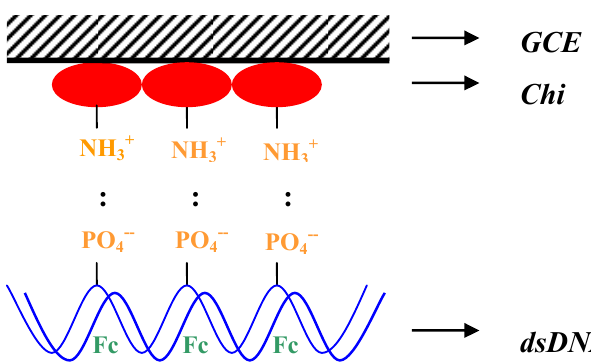
Figure 1. Scheme of the molecular mechanisms underlying electrochemical DNA detection with ferrocene. After chemical modification of the glassy carbon electrode (GCE) surface with chitosan (Chi), the free amino groups (NH 3+ ) of chitosan monomers electrostatically bind the outer phosphate groups (PO 4- ) of a single-stranded DNA which, by this way, becomes immobilized on the surface of the electrode. Afterwards, a second, complimentary DNA chain hybridizes with the former and the ferrocene indicator (Fc) binds double-stranded DNA (dsDNA) through its major grooves or electrostatic